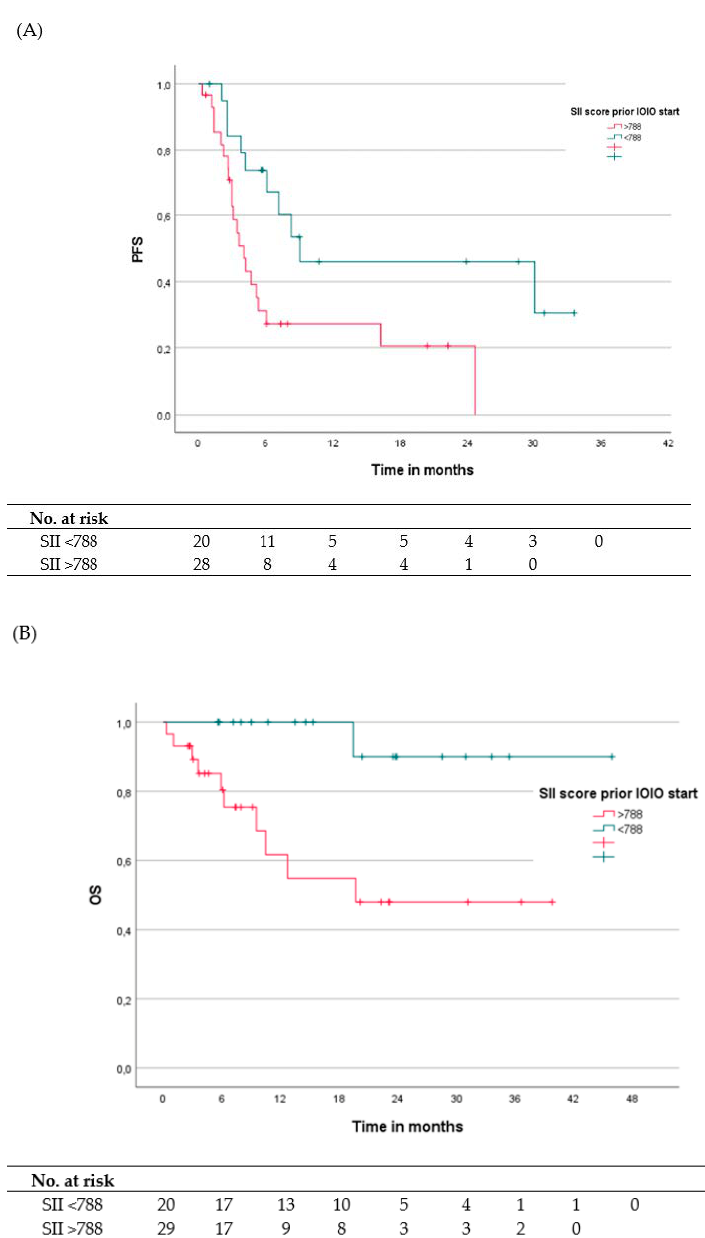
Figure 1. ( A ) Kaplan-Meier analyses illustrating PFS depending on SII score with a cutoff value of 788. PFS defined as time from start ipilimumab plus nivolumab to tumor progression. ( B ) Kaplan-Meier analyses for OS depending on SII score with a cutoff value of 788. OS is defined as time from start ipilimumab plus nivolumab to death/last follow-up. The 1-year PFS rates were 45.9% and 27.4% for SII < 788 and ≥ 788, respectively, and the 1-years OS rates were 100% and 61.7% for SII < 788 and ≥